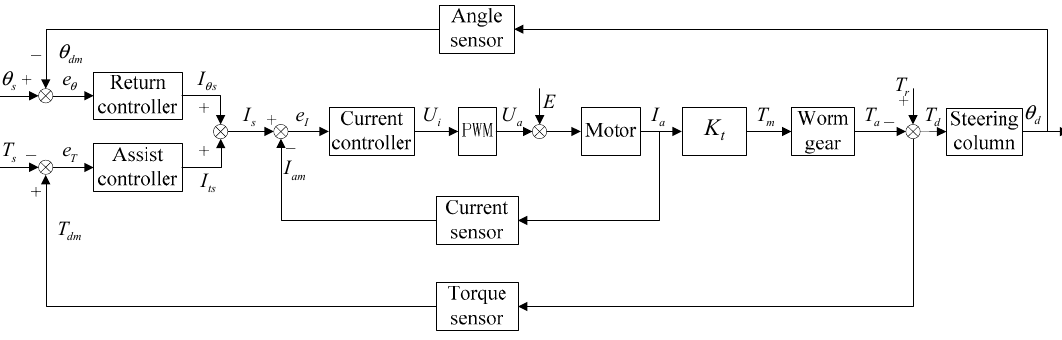
Figure 4. Structure of the EPS control system.